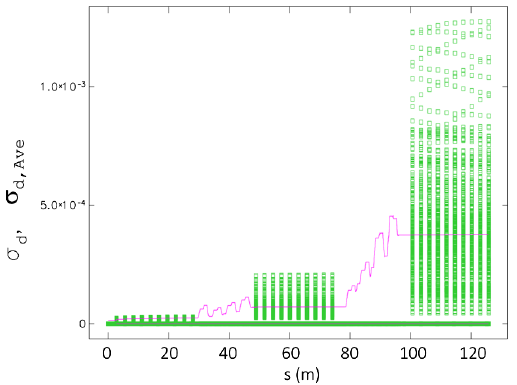
FIG. 7. Slice rms fractional energy spread along RIBS, one turn. Same legend as in Fig.